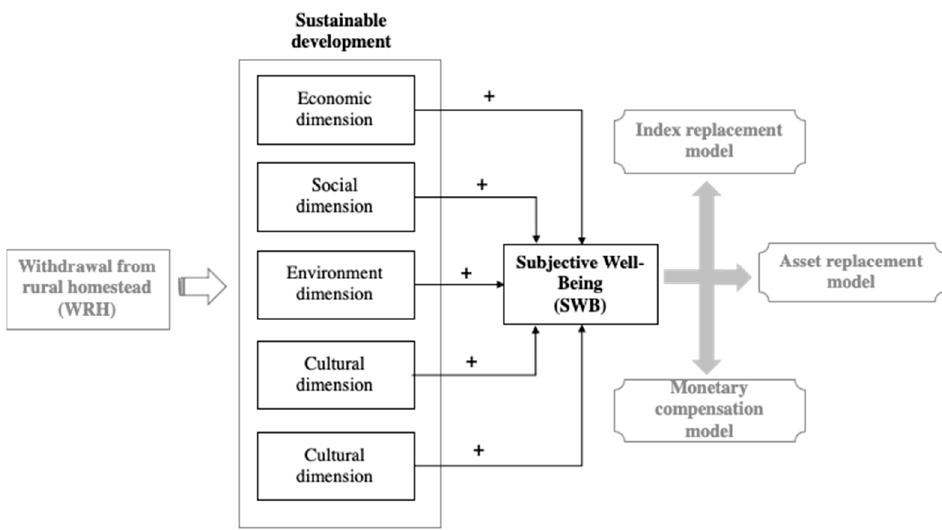
Figure 1. Research framework. Notes: Drawn by the authors.